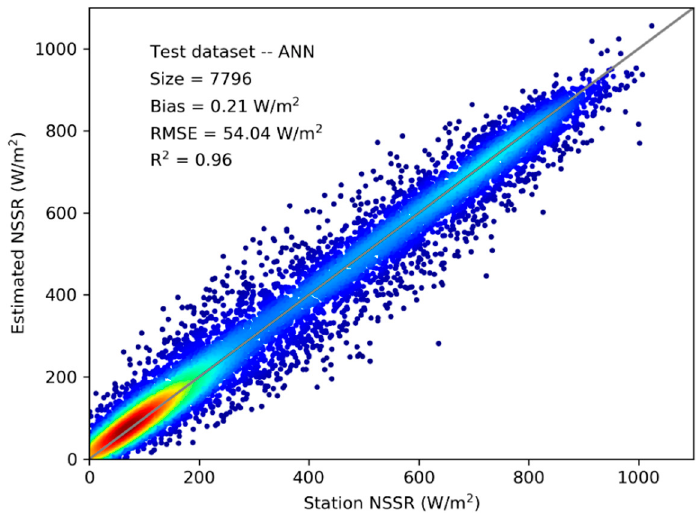
Figure 7. Comparison of NSSR estimated by the ANN method with in-situ observations in the test